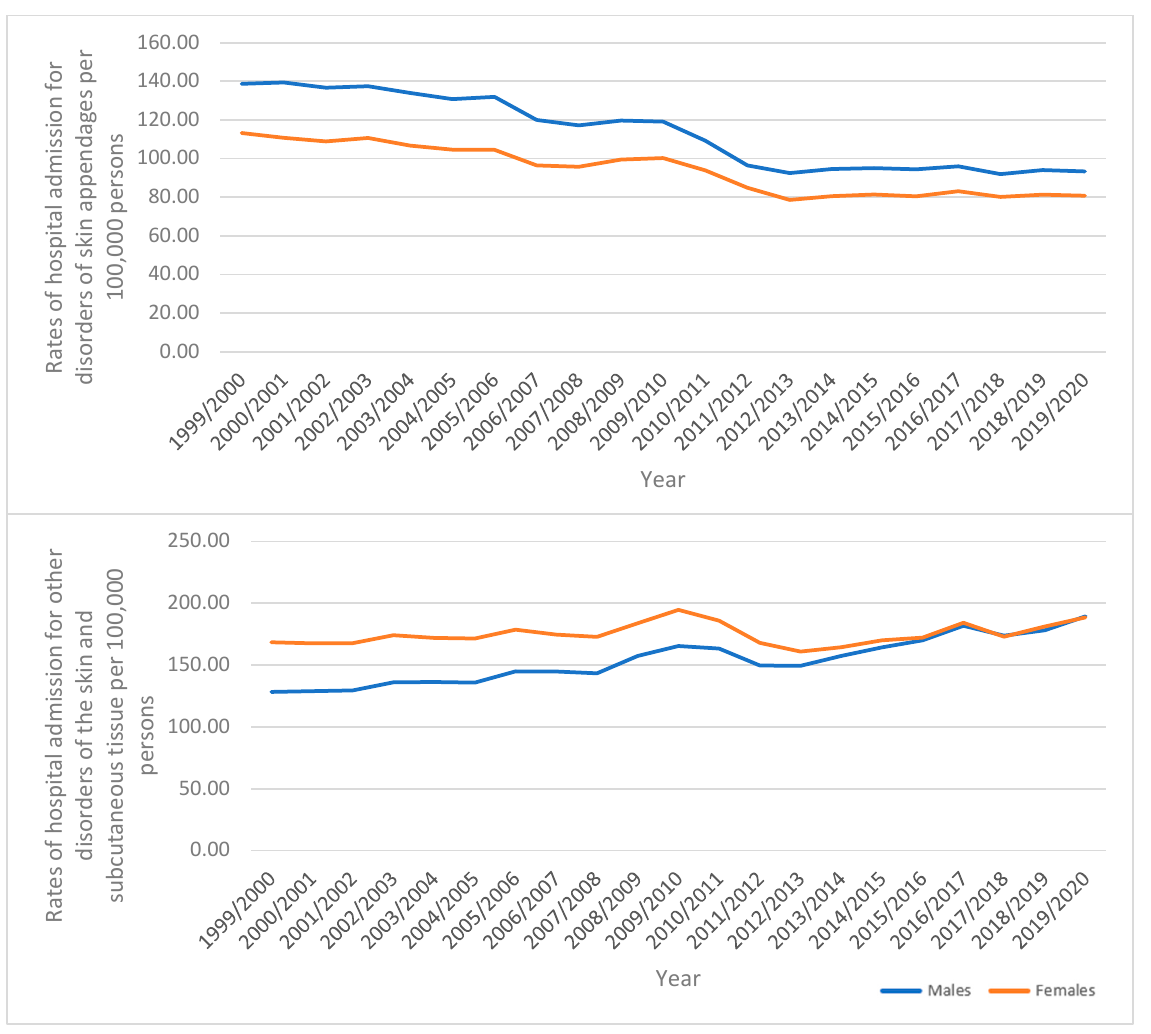
Figure 4. Hospital admission rates stratified by sex. 3.2. Diseases of the Skin and Subcutaneous Tissue Admission Rate by Age Group Multiple types of hospital admissions, such as infections of the skin and subcutaneous tissue, bullous disorders, radiation-related disorders of the skin and subcutaneous tissue, and other disorders of the skin and subcutaneous tissue, were observed to be directly related to age (more common among the age group of 75 years and above). However, the age groups of those under 15 years, over 75 years, between 60 and 74 years, and between 15 and 59 years had higher rates of hospital admissions for “dermatitis and eczema” and “urticaria and erythema”, respectively. The age groups of 15–59 years, 60–74 years, 75 years and above, and under 15 years experienced higher rates of hospital admissions due to disorders of skin appendages. Hospitalizations for papulosquamous disorders were more frequent in the following age groups: 60–74 years, 15–59 years, 75 years and older, and under 15 years, respectively (Figure 5).